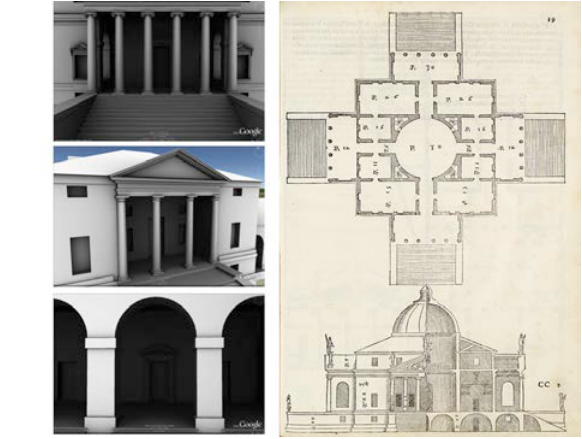
Figure 9. 2D to 3D visualization: from plates to GE The KMZ file contains a set of characteristics that define the model (placemarks, images, polygons, 3D models, textual descriptions, etc..) and allows its placement on the 3D model of the Earth.